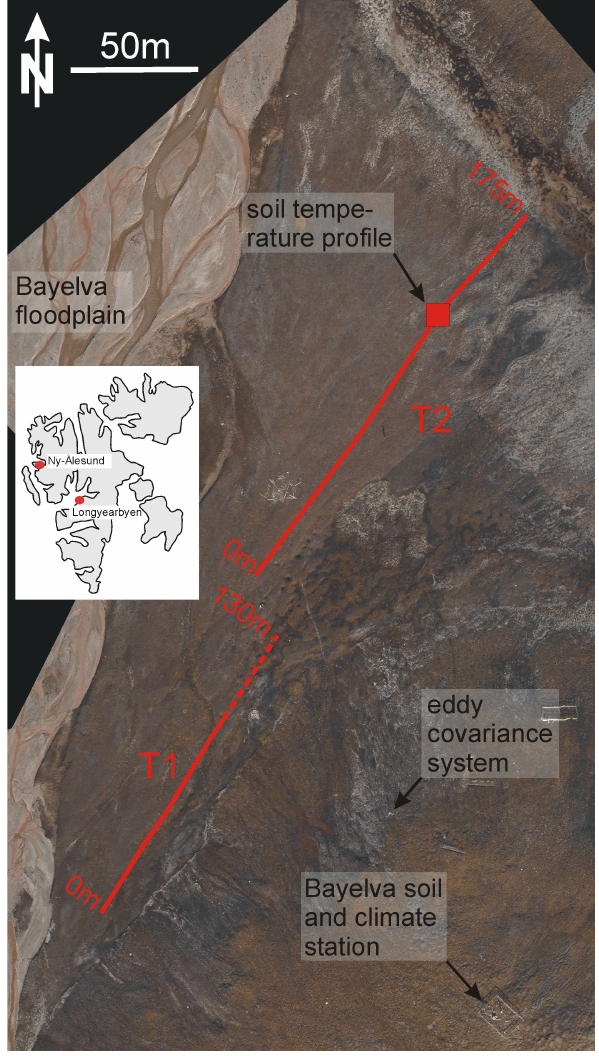
Fig. 1. Orthorectified aerial image of transects T1 and T2 (both transects aligned from SW to NE) acquired on 29 August 2008. The dashed part of T1 depicts the section where the radargrams cannot be evaluated (see Fig. 2). The vegetated flat gravel plain, in which the radar transects are located, is bordered by Leirhaugen hill to the SE, on which the eddy covariance system and the Bayelva station are located (elevation difference between the radar transects and the Bayelva station approximately 10m). To the W of the transects is the floodplain of the Bayelva river, which flows S to N. Transect T2 ends at the banks of a small stream visible in the NE corner. The inset map shows the location of Ny- ˚Alesund where the study has been performed on